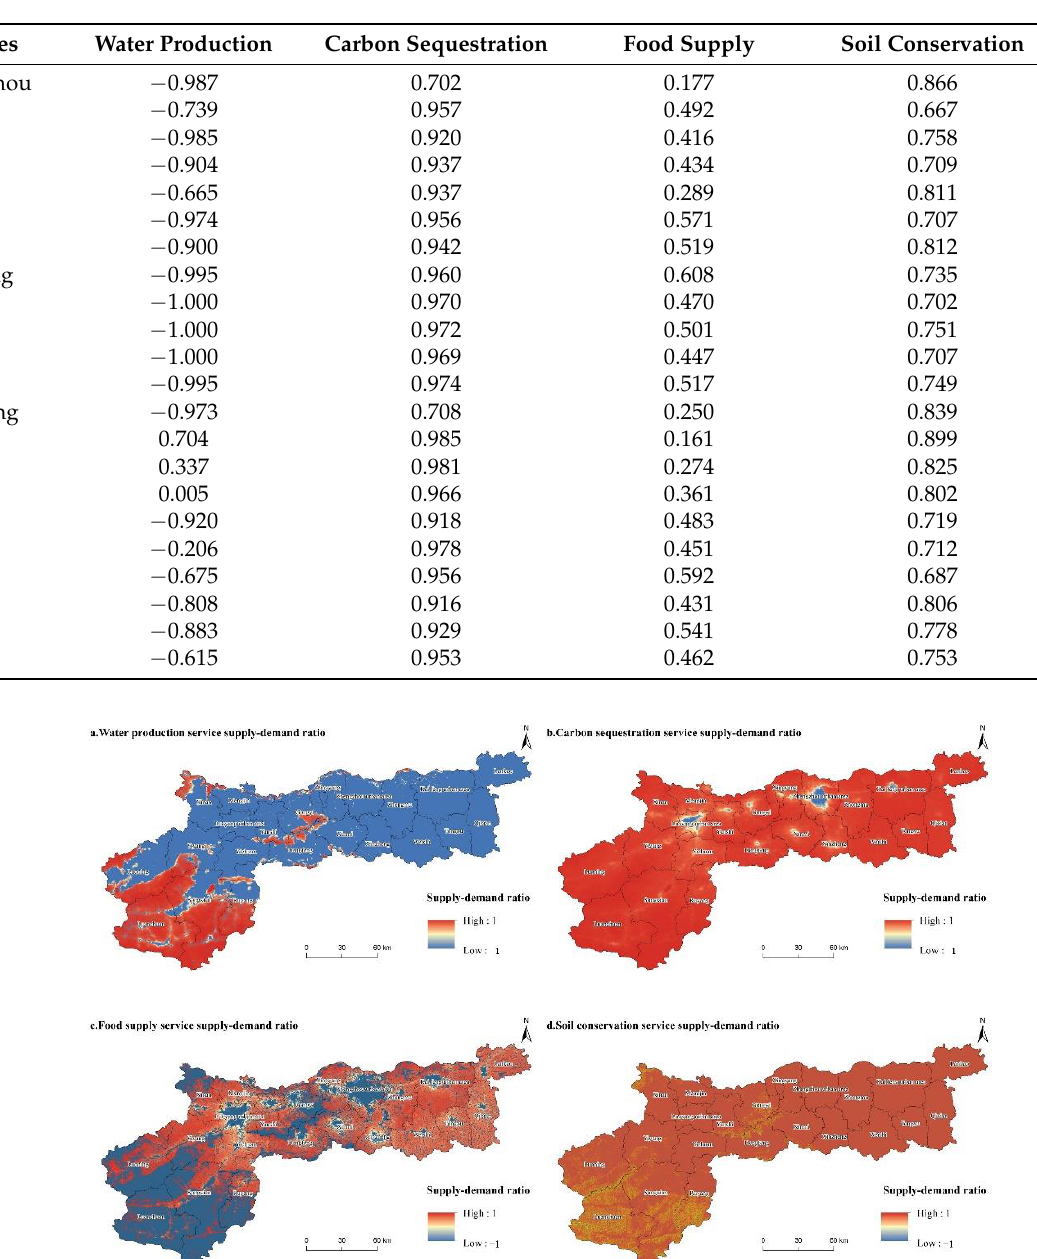
Table 3. Supply-demand ratios of ESs in all the districts and counties in the ZKL urban agglomeration.